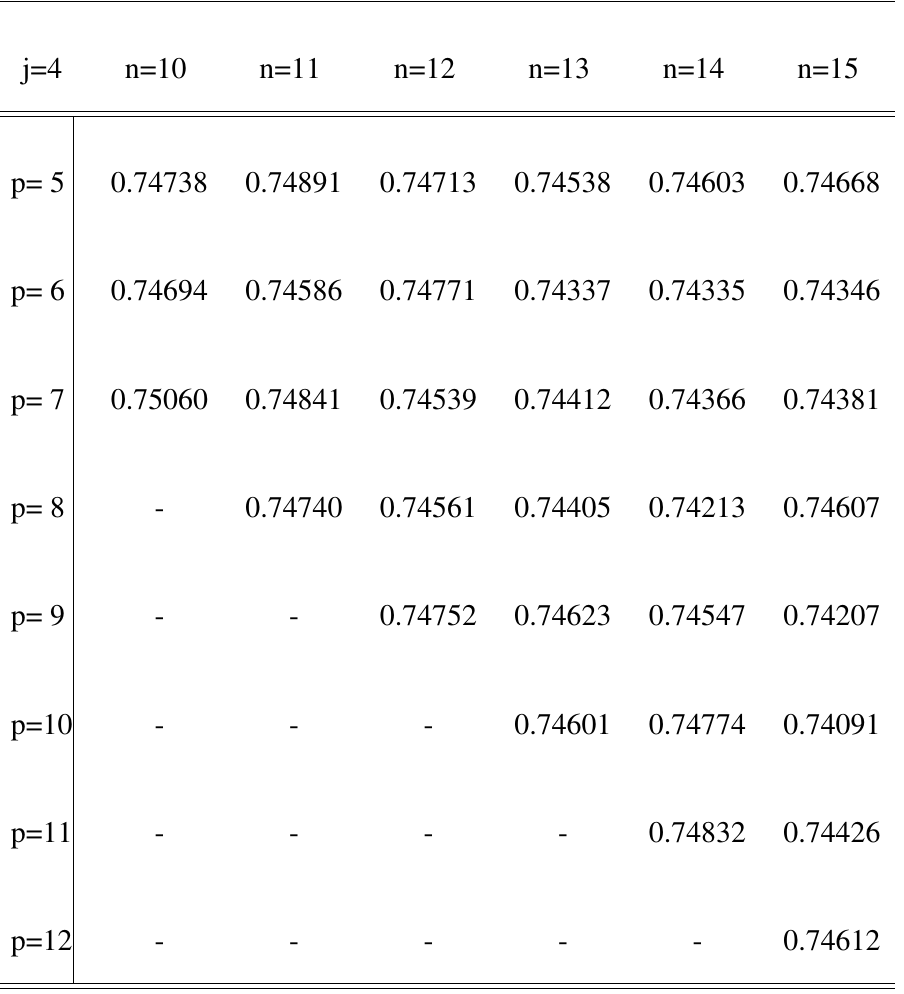
Table 3: Average Value of Dominance for different values of n and p for j = 4 sigma = 1